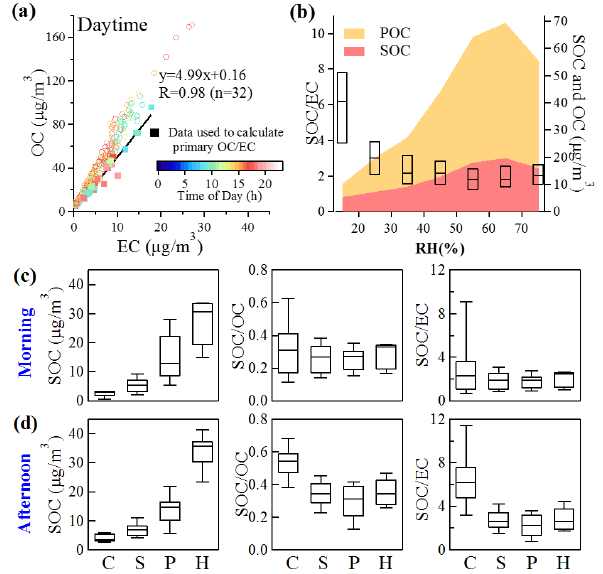
Figure 9. Evaluation of SOC formation. (a) Estimation of SOC with EC-tracer method. Squares indicate data used to calculate primary OC / EC, while open circles indicate other OC / EC data. (b) Change of SOC, OC and SOC / EC with RH. Data points shown in (a) and (b) referred to hourly concentrations in daytime (07:00–18:00). (c– d) Variation of SOC, SOC/OC and SOC / EC (c) in the morning (07:00 ∼ 12:00) and (d) in the afternoon (13:00 ∼ 18:00) with pol- lution level. “C”, “S”, “P”, “H” refer to “clean”, “slightly polluted”, “polluted” and “heavily polluted”, respectively. In the box-whisker plots, the boxes (b, c, d) and whiskers (c, d) indicated the 95th, 75th, 50th (median), 25th and 5th percentiles, respectively.